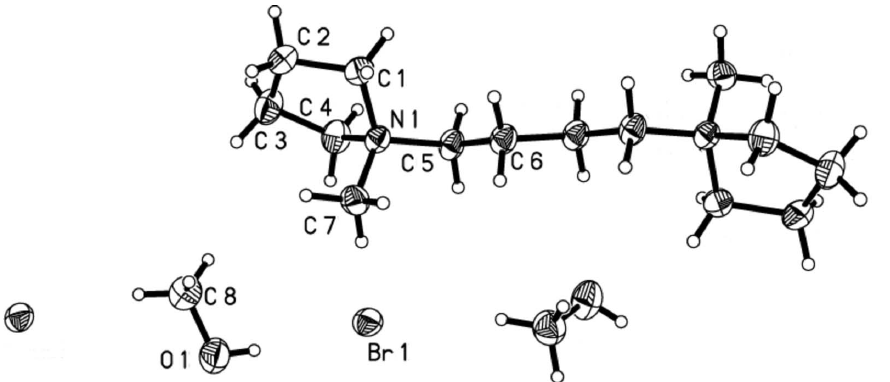
Figure 1 View of the molecule of (I) showing the atom-labelling scheme. Displacement ellipsoids are drawn at the 50% probability level. Labelled atoms are related to unlabelled atoms by the symmetry operation- x + 1,- y ,- z + 2.